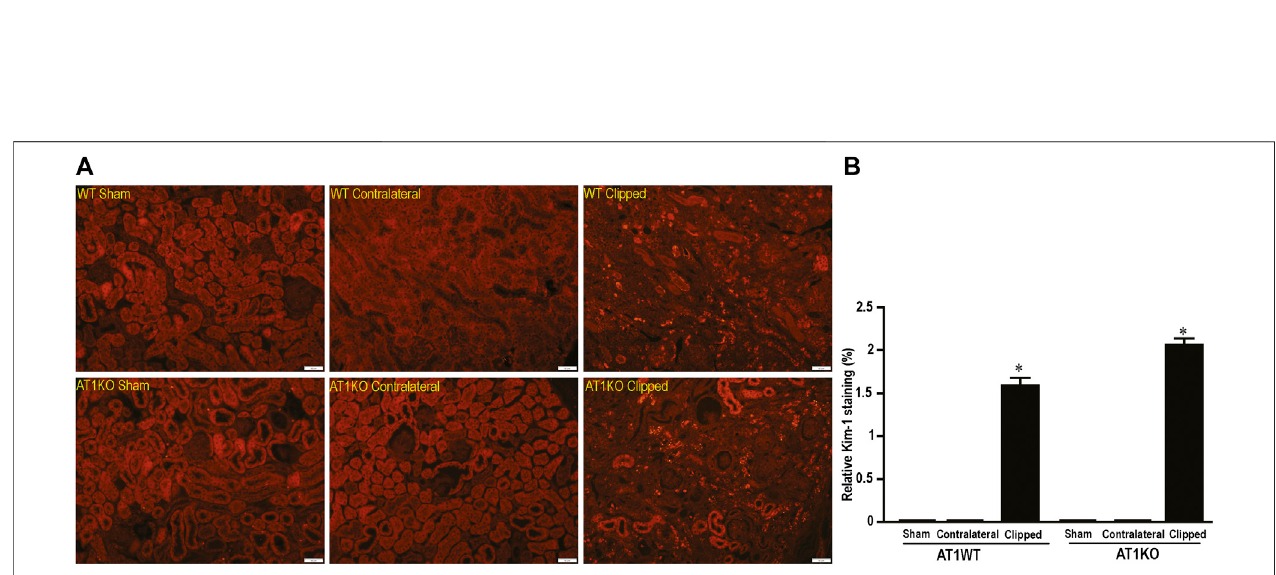
FIGURE13| Representativelightmicroscopyimagesofkidneysectionfromsham,clippedandcontralateralkidneyfromWTandAT1KOmicestainedwithKIM-1. Magni fi cation: × 20, scale bars: 50 μ m. (B) Semiquantitative scores of KIM-1 analyzed by Metamorph. There was a signi fi cant increase of renal KIM-1 expression in the clipped kidneys of both WT and AT1KO mice. Each bar represents mean ± SEM. (n (cid:2) 4 – 5, * p < 0.001 vs. sham controls). ± ±